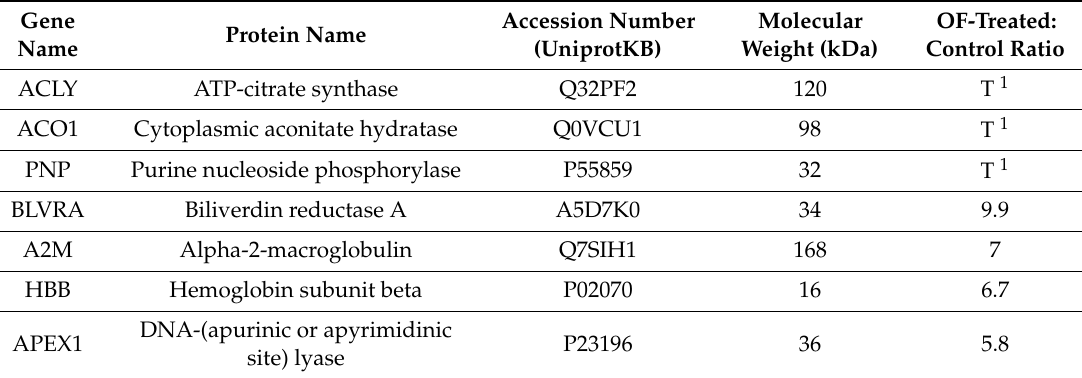
Table 2. Proteins identified as interacting with embryos at the morula